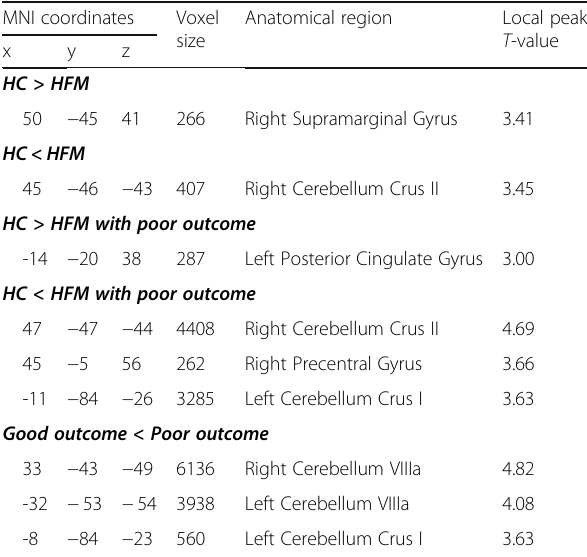
Table 2 Difference in GMV among patients with HFM with different outcomes and HC MNI coordinates Voxel Anatomical size